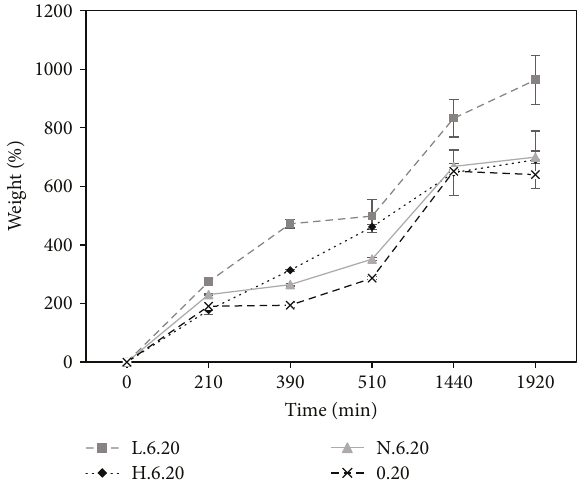
Figure 3: Swelling kinetics for four formulations of hydrogels incubated in PBS. The four samples were 0.20 solely gelatin (20% gelatin), N.6.20 (6% NOP and 20% of gelatin), H.6.20 (6% HOP and 20% of gelatin), and L.6.20 (6% LOP and 20% gelatin).